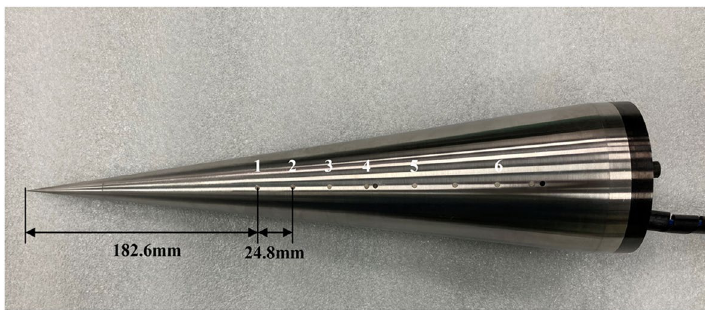
Fig. 2 7-degree half-angle cone model instrumented with PCB sensors